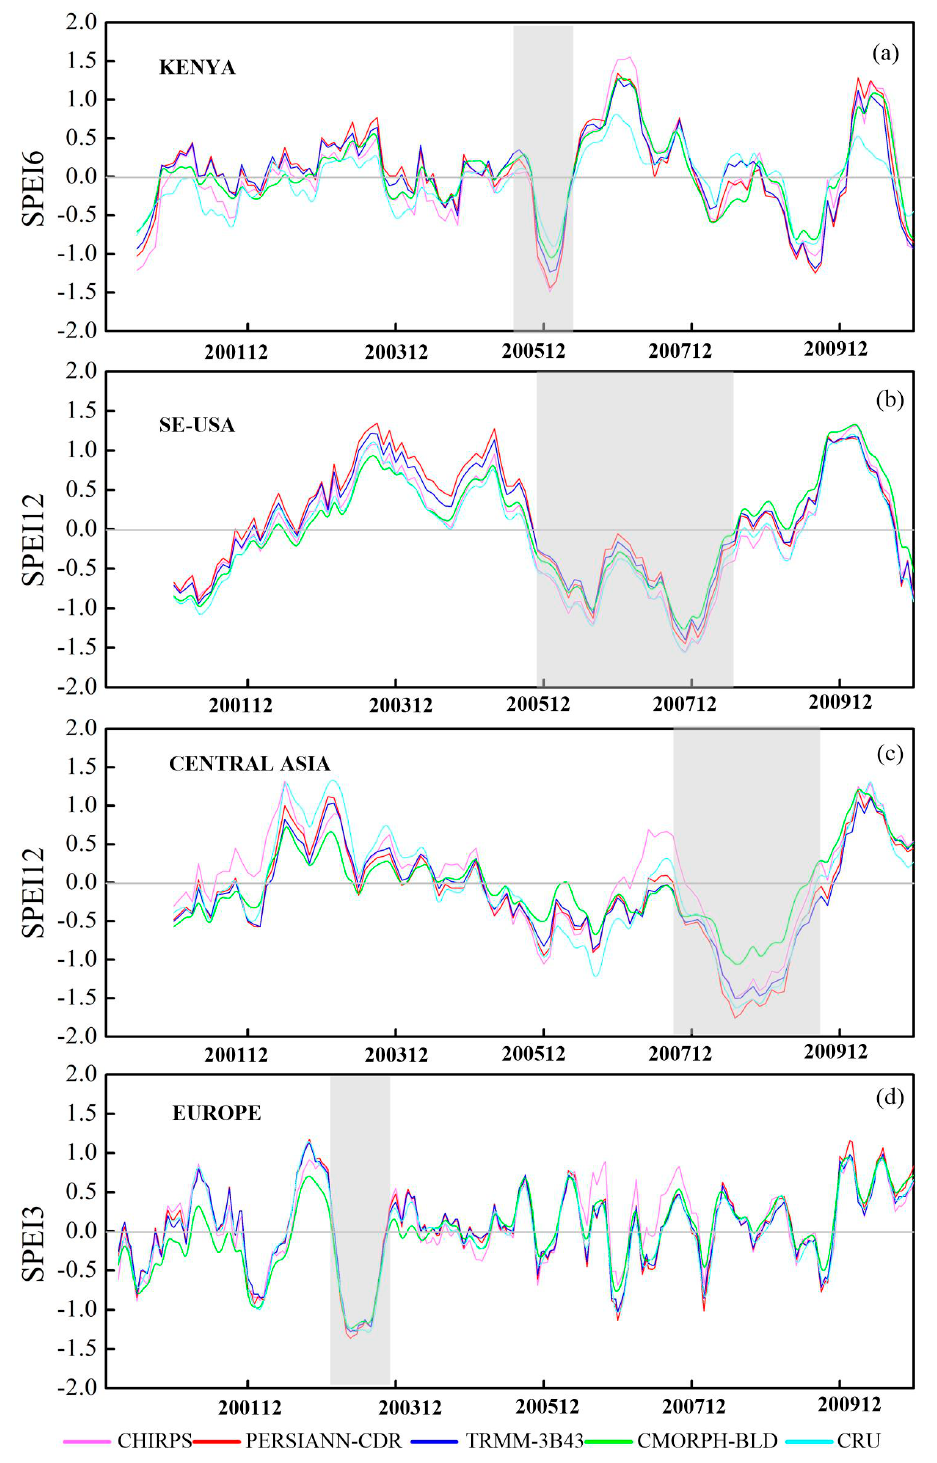
Figure 6. Areal averaged SPEIs for four drought events from 2000 to 2010 ( a – d ). The specific domain of the drought event is shown in Table 5.